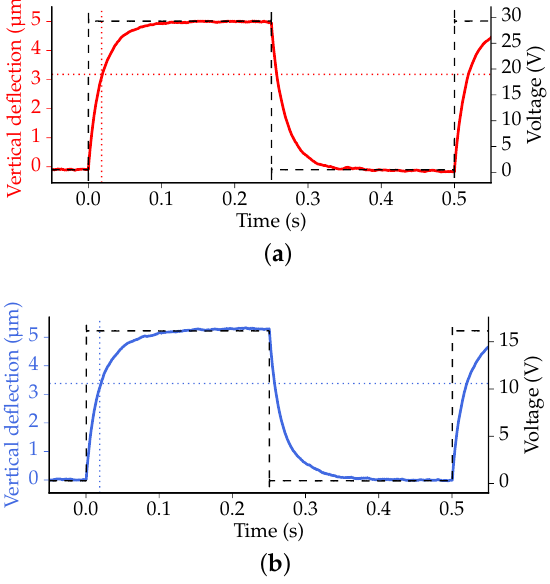
Figure 16. The vertical deflection (solid line) of a point on the crossbar resulting from an applied square wave voltage (dashed line). The plots indicate the 63.2% level (horizontal dotted line) and the corresponding time value (vertical dotted line). ( a ) Actuators with 3µm poly-Si thickness; ( b ) actuators with 5µm poly-Si